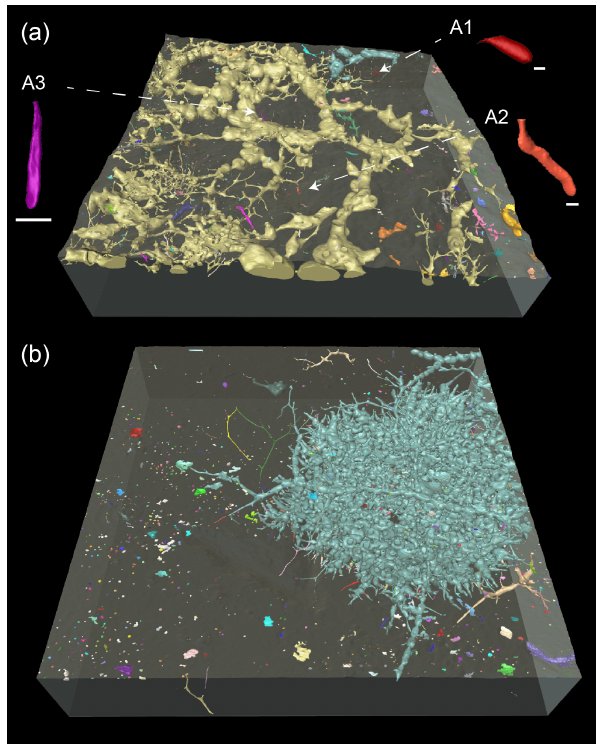
Figure 4. Micro-computed tomographic visualisation of bioerosion traces in three subsamples of the 7-year block. (a) First subsample of the block with Entobia cf. mammilata , (b) second subsample of the block showing two specimens of E. megastoma (B1 and large chambers B2) and E. mammilata (small chambers B2), and (c) third subsample of the block with E. mammilata (C1) and E. megastoma (C2) (scales = 10mm; size of blocks is 90 × 90 ×